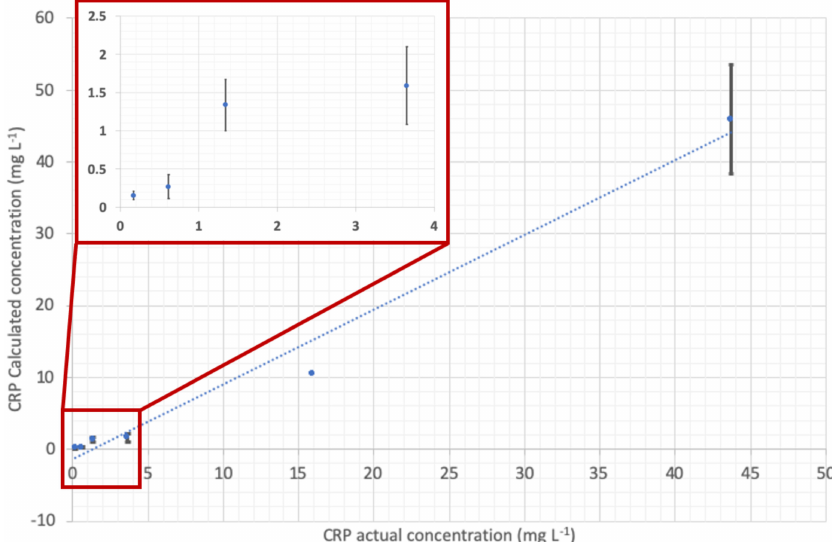
Figure 8. Correlation between CRP actual concentration measured in the hospital and CRP calculated concentration measured with the POCT prototype. A zoom-out of the first four measurements is reported in the red square, for a better reading of the